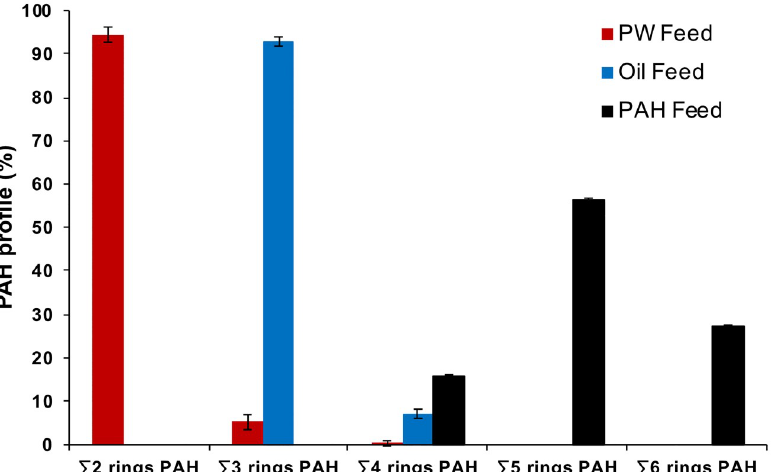
Fig 1. PAH profiles (% of total PAH) in the three exposure feeds; Produced Water ( PW ), oil fraction ( oil ) and heavy PAH mixture (n = 3).